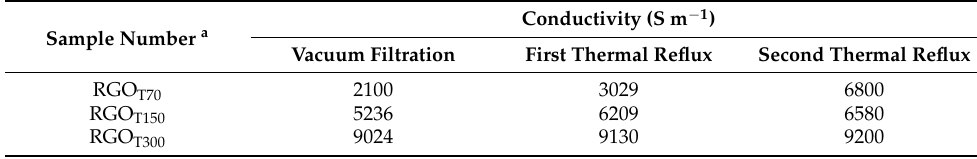
Table 5. The conductivity of thermally extracted